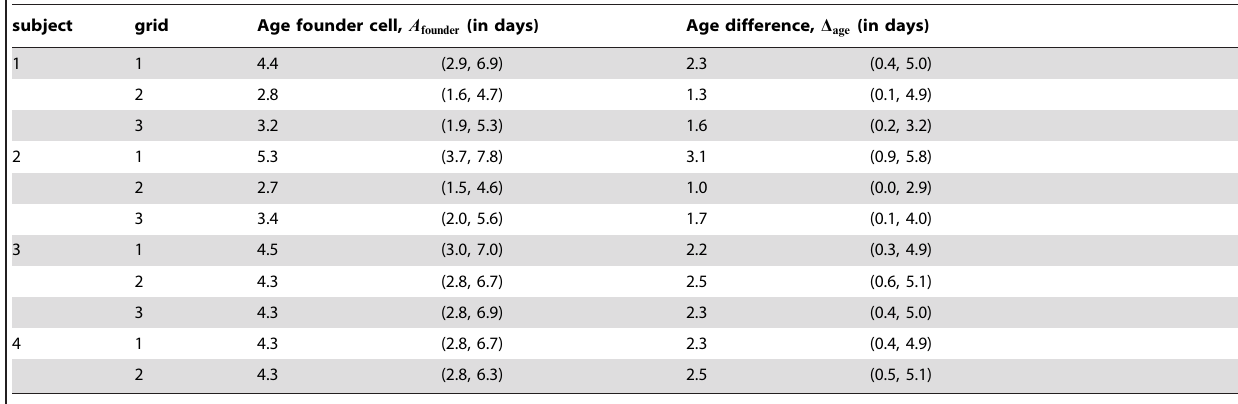
Table 2. HCV RNA and age of